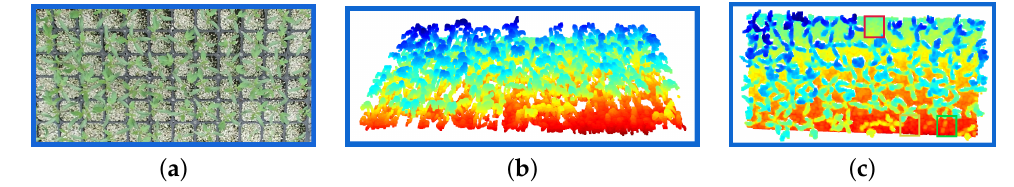
Figure 7. Tray Extraction. ( a ) A 12 x 6 cavity tray of tomato seedlings; ( b ) the point cloud where the color in the seedling indicates the height variation from red being the lowest to blue the highest; ( c ) the top-down scan of the tray shown in ( a ). The red, yellow, and green boxes correspond to failures.